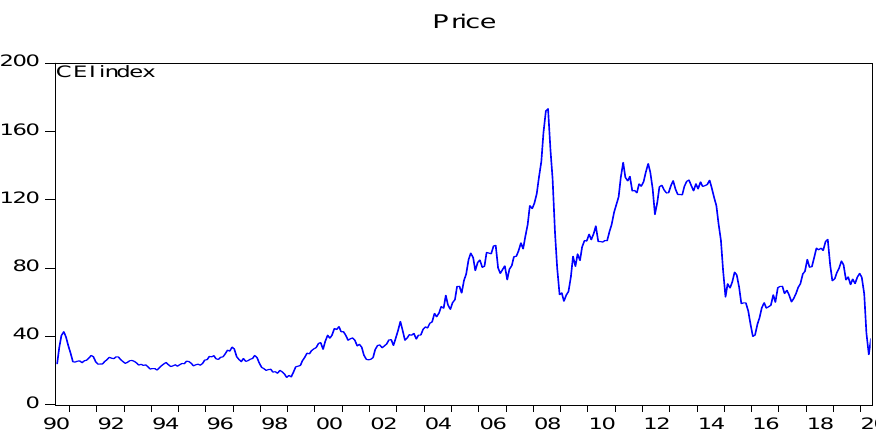
Figure 2. Plot of West Texas Intermediate (WTI) Crude oil price per barrel.